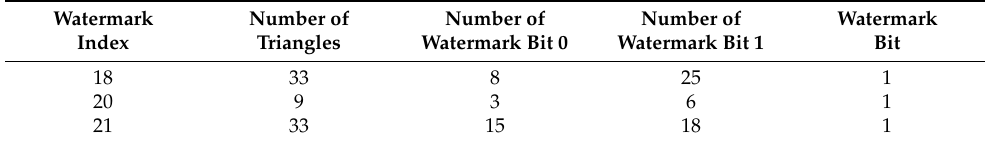
Table 5. The watermark index and the watermark bit. Watermark